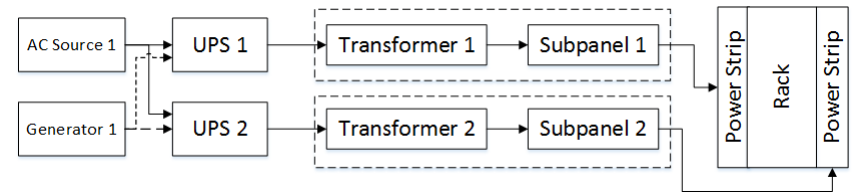
Figure 16. A6: data center power architecture.